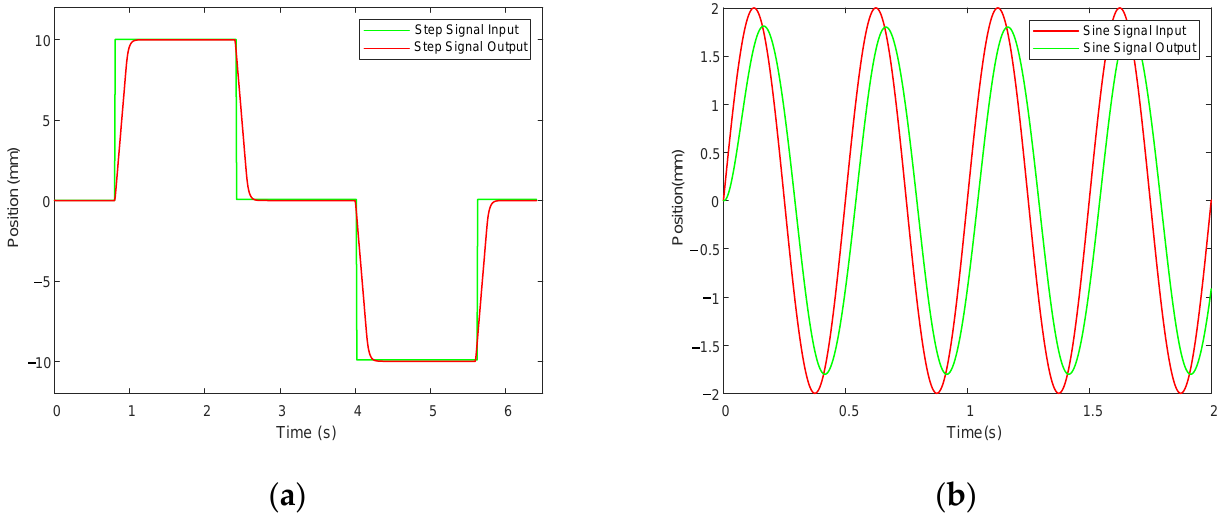
Figure 5. Simulation response to different inputs. ( a ) Response to step input; ( b ) Response to sinusoidal input.